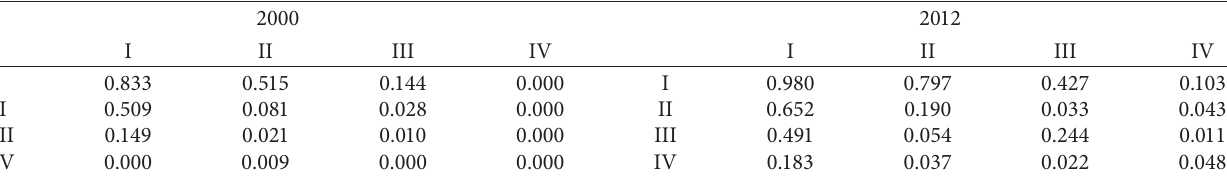
Figure 7: Cohesive subgroups of the producer services trade network in 2000 and 2012. Table 5: Density matrix of cohesive subgroups of the producer services trade